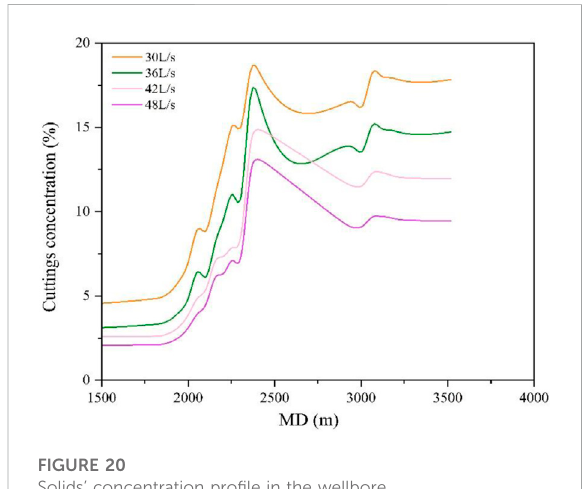
FIGURE 20 Solids ’ concentration pro fi le in the wellbore.